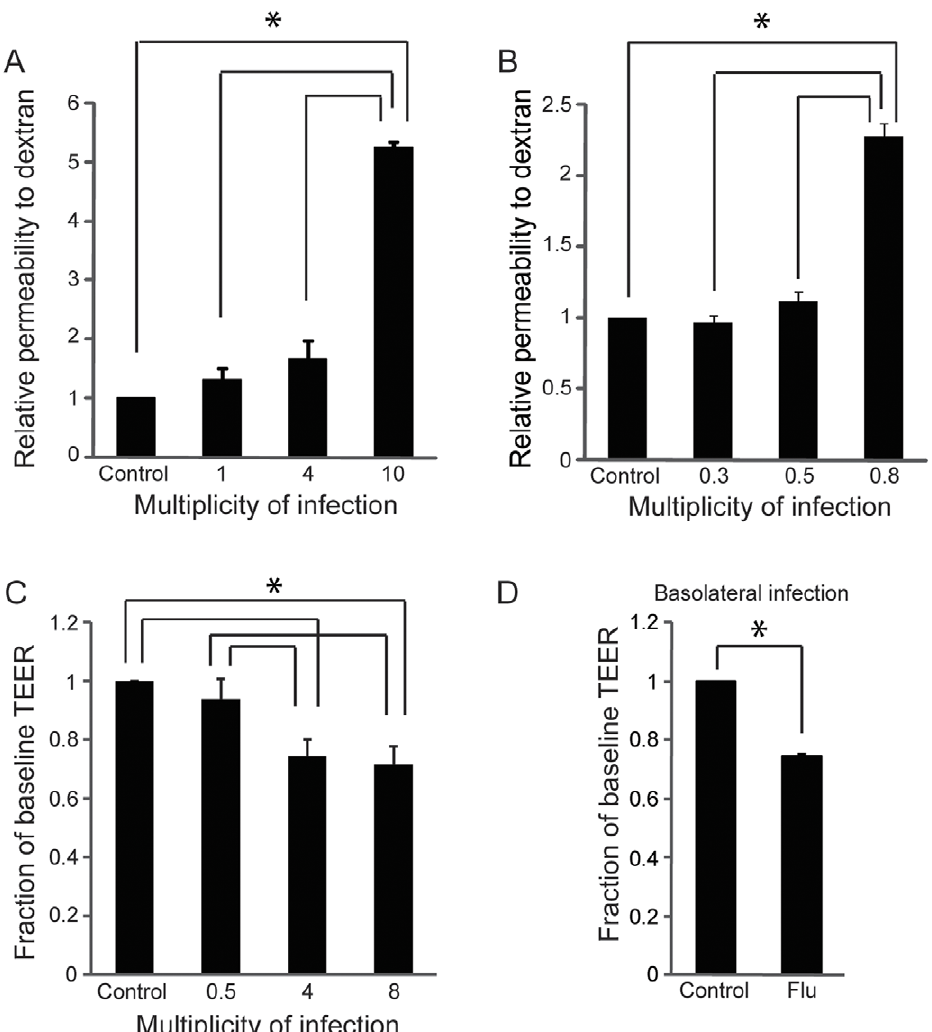
Figure 2. Human influenza induces lung endothelial permeability. (A) Influenza induces an increase in permeability to dextran in a dose- dependent fashion. Cells were infected at the indicated multiplicity of infection (MOI) for 24 hours before permeability to dextran was analyzed. Results (mean, SD) are experiments and are normalized to control, *p , 0.05 versus control. (B) A clinical H3N2 influenza isolate was used to infect lung microvascular endothelium for 24 hours. Permeability to dextran was measured as in A. Results (mean, SD) are from 3 experiments and are normalized to control, *p , 0.05. (C) Similar to A, except the transendothelial electrical resistance (TEER) was measured before and after infection. Results (mean, SE) are from 3 experiments and are normalized to control, *p , 0.05. (D) Influenza induces endothelial permeability even after infection from the basal aspect. Human lung microvascular endothelium seeded on transwells was infected from the basal aspect of the transwell (MOI 8) and the change in TEER was measured 24 hours later. Results (mean, SD) are from 2 experiments and are normalized to control, *p ,